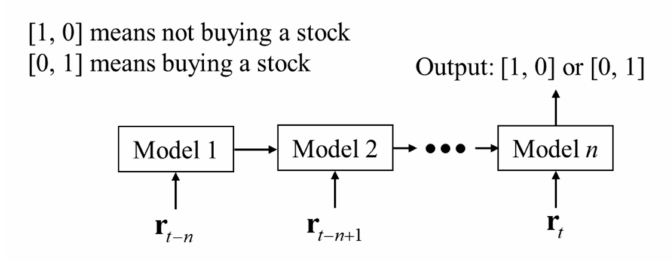
Figure 2. “Many to one” architecture for the classification of stocks.